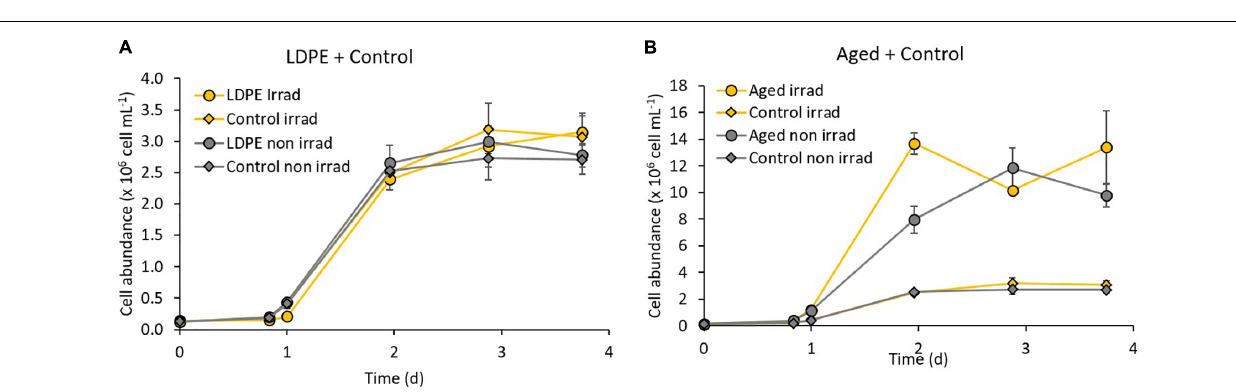
FIGURE 3 | Growth of natural bacterial communities on (A) LDPE leachates and (B) aged plastic leachates produced during the abiotic degradation experiment (irradiated and non-irradiated). The controls with no plastics are also shown. Error bars represent the standard deviation of the mean of the triplicate cultures. Note the different scales of cell abundance in panels (A,B)